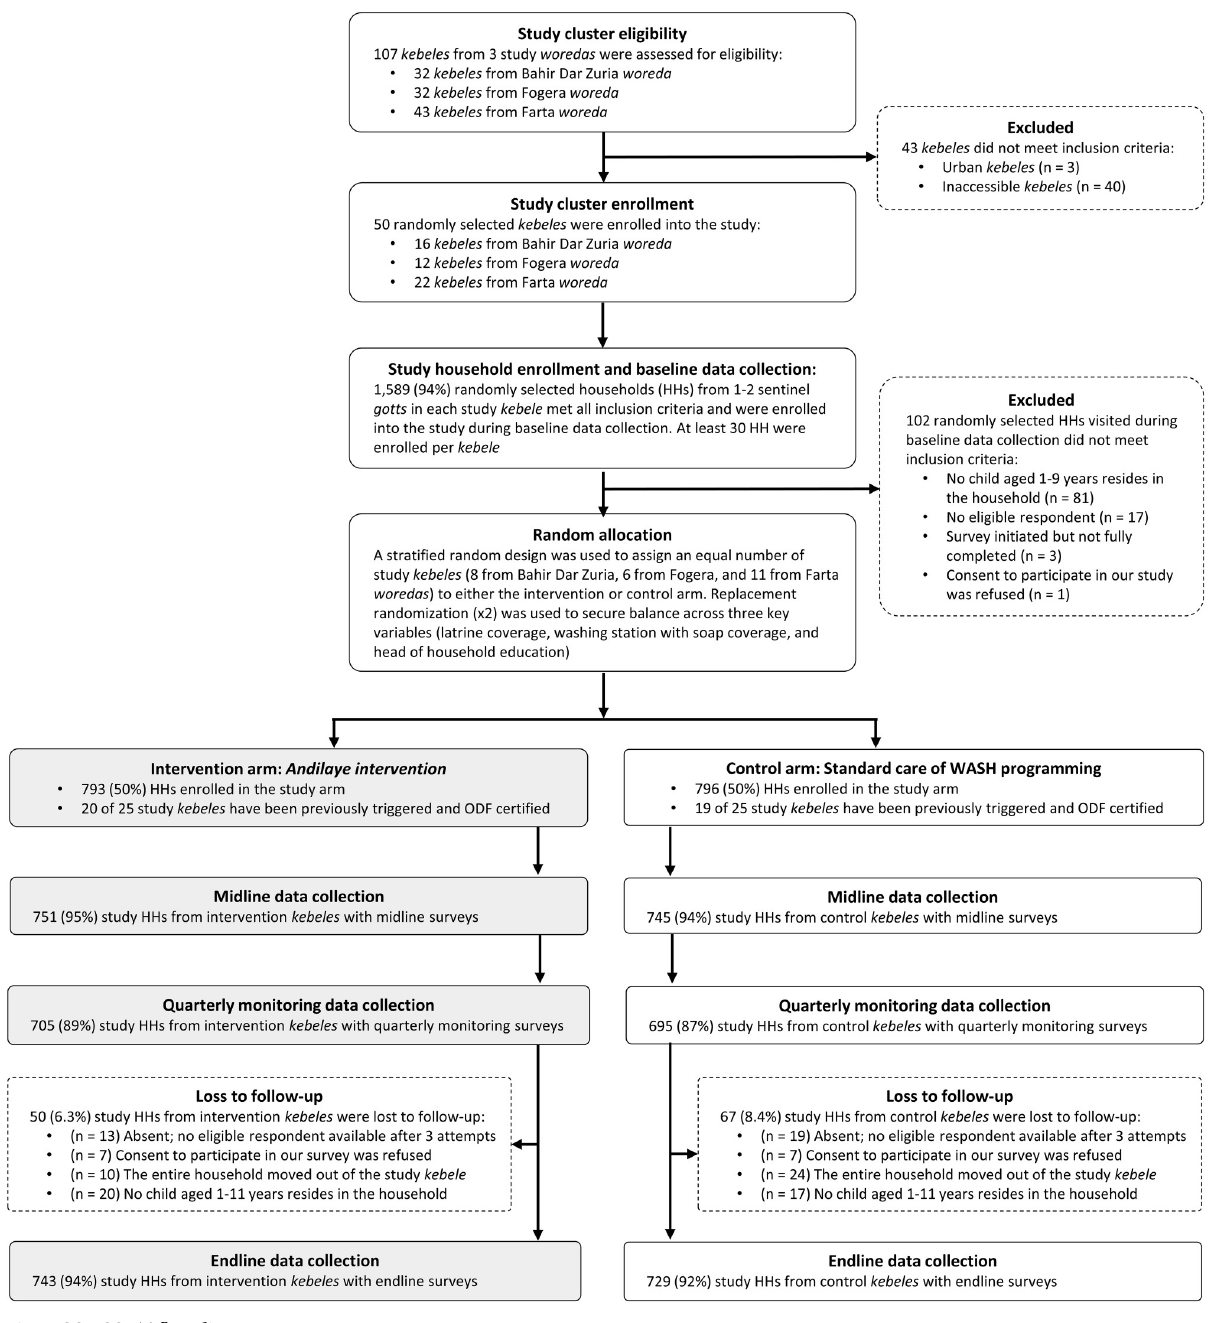
Fig 1. CONSORT flow